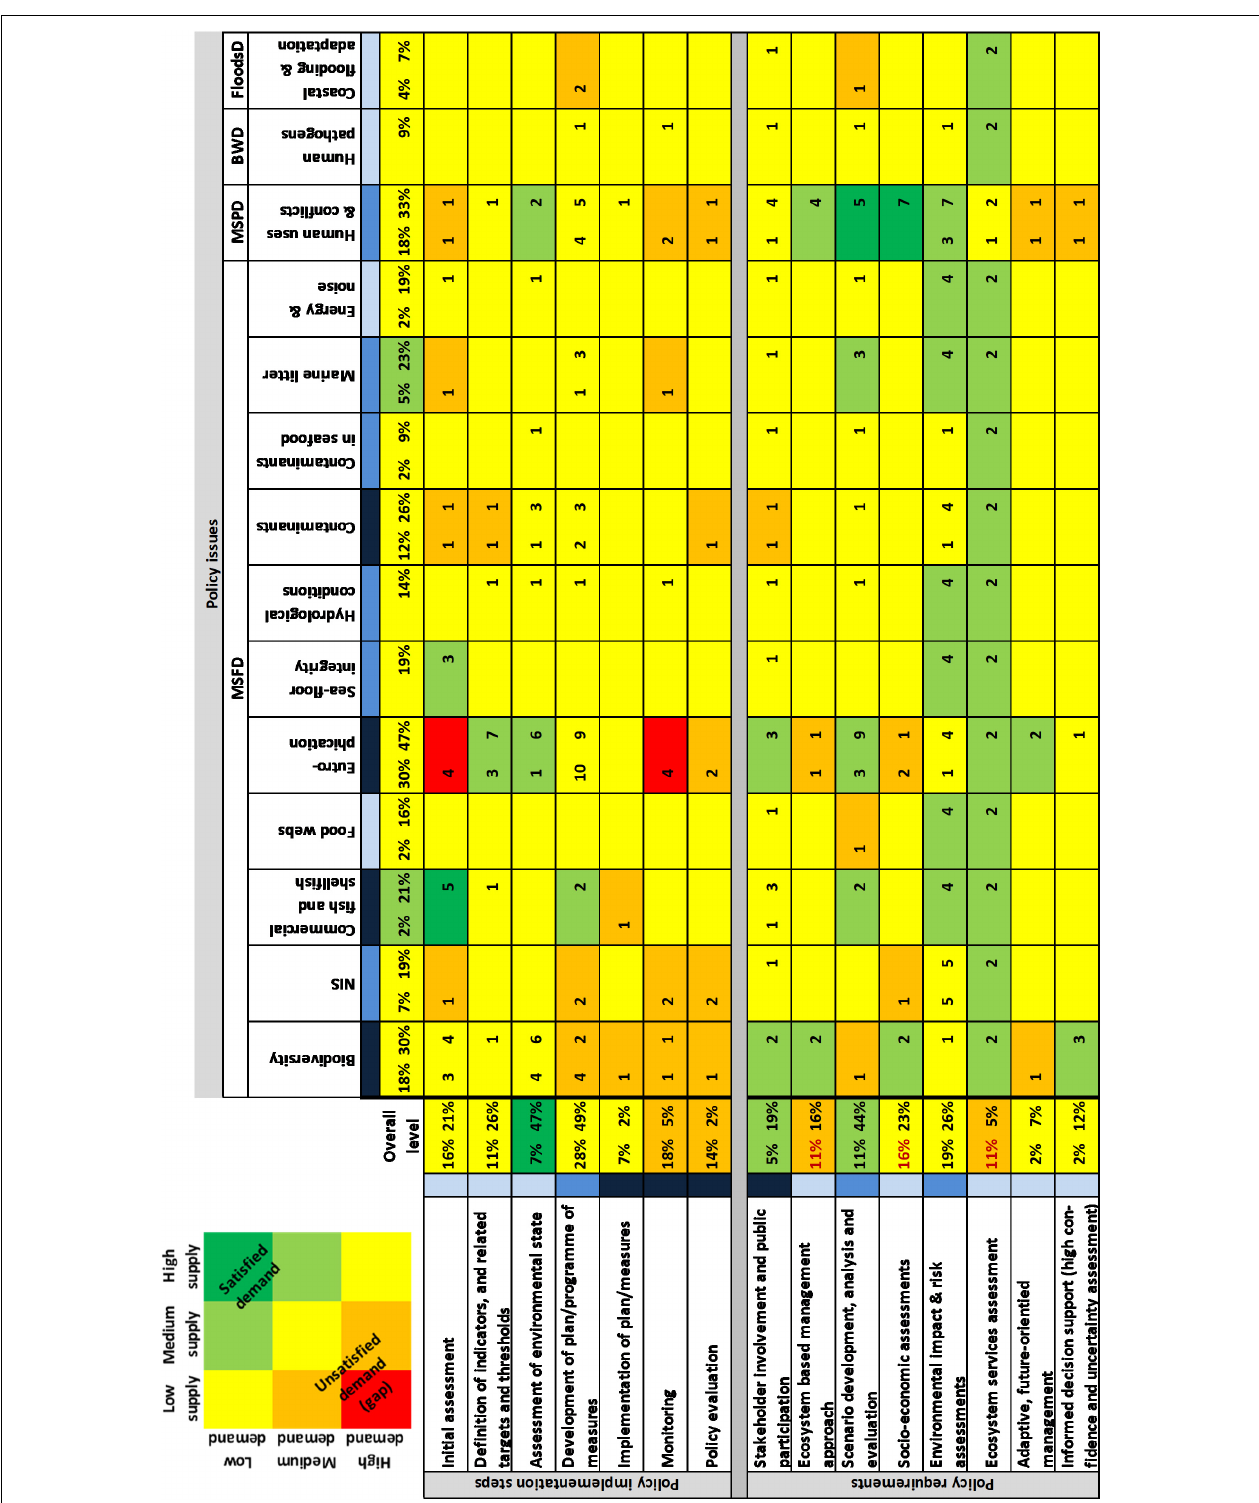
FIGURE 5 | In the gap analysis DST supply and DST demand are compared on a categorical scale. On the overall level, the scale indicated in the synthesis-matrix is used. In the inner matrix, the categorical scales for DST supply is low (0–1 DST), moderate (2–4 DSTs), high (5 or more DST) and for DST demand low (0 end-users), medium (1–3 end-users), high (4 or more end-users).